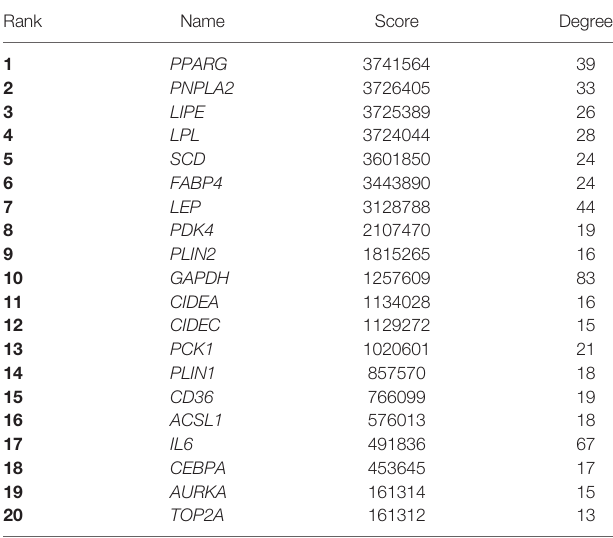
TABLE 4 | Top 20 Hub gene in PPI network ranked by MCC method.